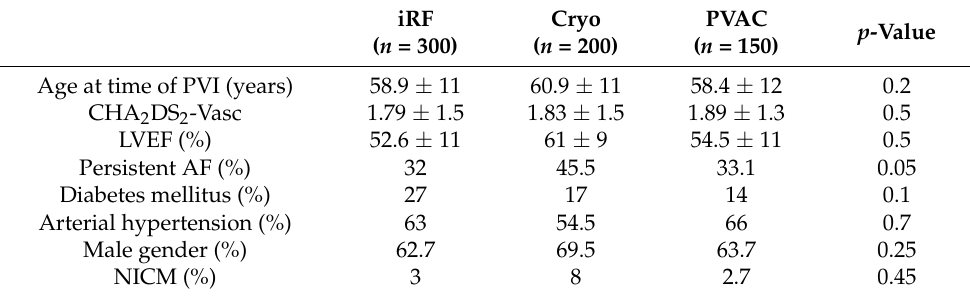
iRF Cryo ( n = 300) ( n = 200)